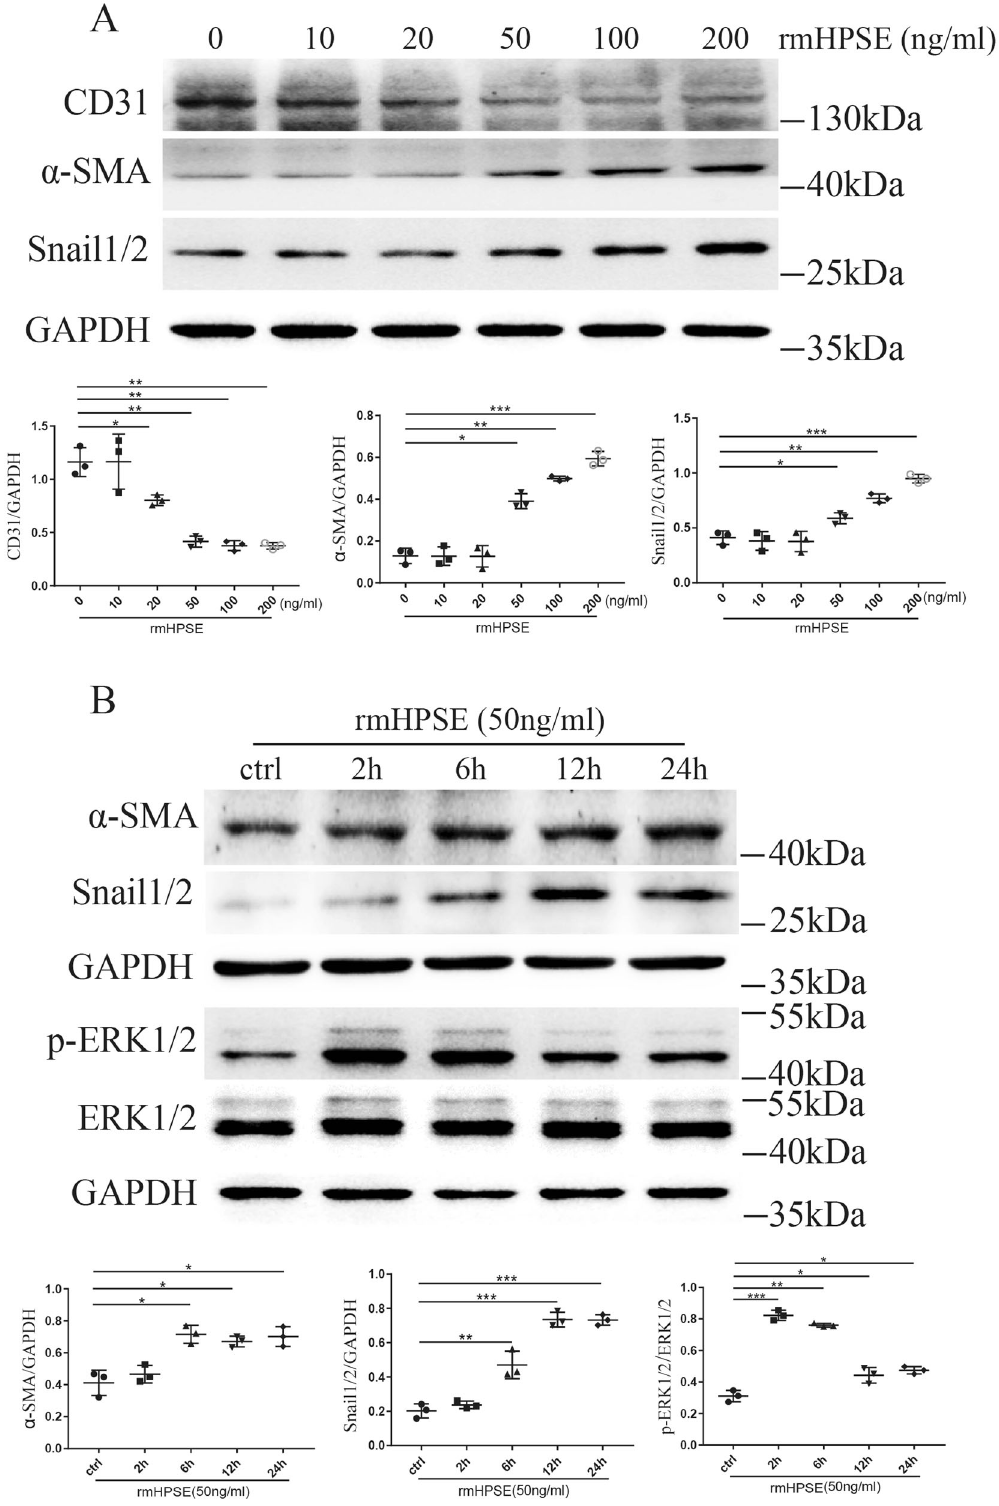
Fig. 6 rmHPSE induced EndMT in cultured GEnCs. A rmHPSE downregulated the protein level of CD31 and upregulated the expressions of α - SMA and Snail1/2 in a dosage-dependent manner. B At the concentration of 50 ng/ml, rmHPSE increased the expressions of p-ERK1/2 and the mesenchymal markers including α -SMA and Snail1/2 in a time-dependent manner. Each vertical bar represents the mean ± SD ( n = 3) analyzed by one-way analysis of variance (ANOVA) followed by Tukey ’ s multiple comparisons test. * P < 0.05, ** P < 0.01, and *** P < 0.001.